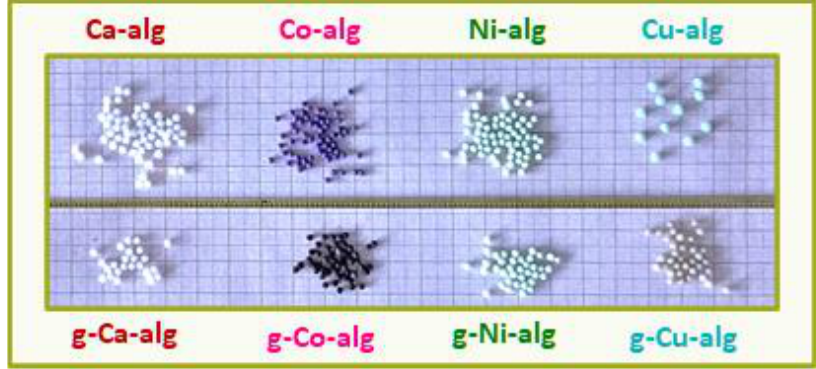
Figure 1. Optical photographs of M-alginate and g-M-alginate aerogels, as indicated. 3.2. Chemical Characterization of PLA-Grafted M-Alginate (g-M-Alginate)